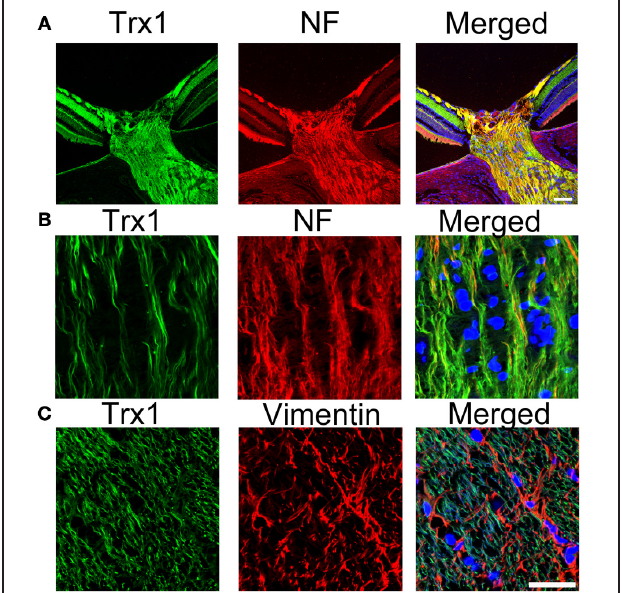
FIGURE 1 | Localization of Trx1 in the optic nerve. (A) and (B) Double staining for Trx1 (green) and neurofilament (red). Substantial co-localization of Trx1 and NF is observed in the PBS-treated optic nerve. (C) Double staining for trx1 (green) and vimentin (red). No colocalization of Trx1 and Vimentin is observed in the PBS-treated optic nerve. Scale bar, 25 μ m. Trx1, trioredoxin1; NF,